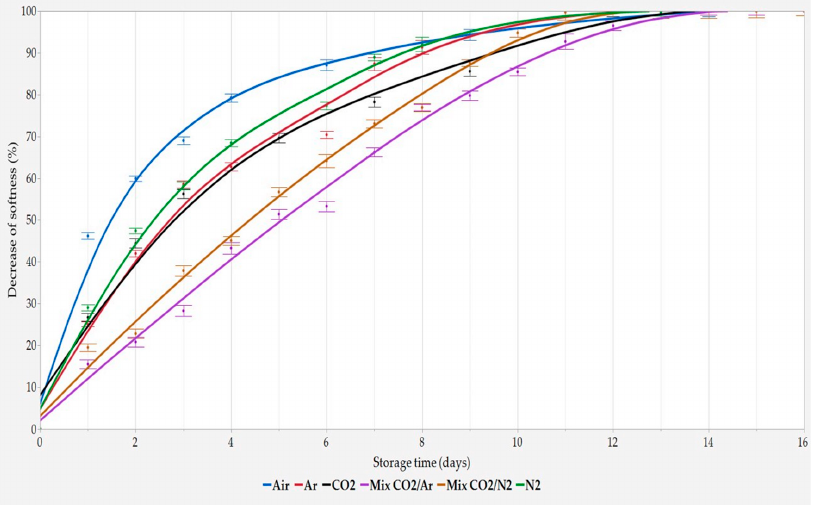
Figure 2. Percentage decrease of softness during storage time. Results are expressed as mean ± SD (n = 4).